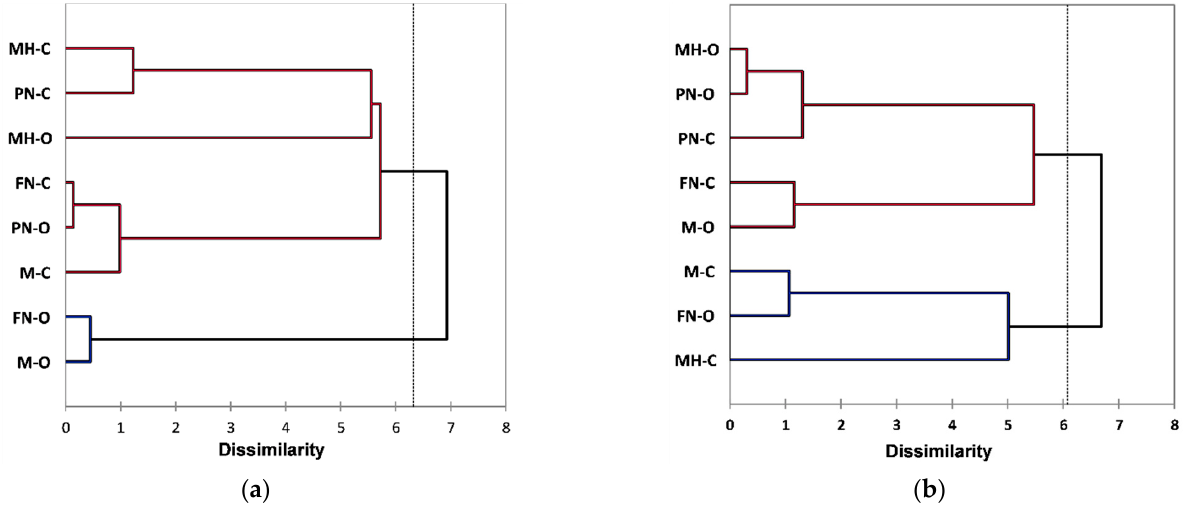
Figure 3. Dendrograms showing the cluster patterns for red grape skin extracts based on: ( a ) FTIR data; ( b ) Raman data. As can be observed for the FTIR data processing using AHC (Figure 3a), classification reveals two main clusters: the first included FN-O and M-O extracts and the second included the rest of the extracts, a good classification based on vineyard type, relative to all four varieties, cannot be observed. However, at a lower dissimilarity level (2 ÷ 5), subclusters division allows a classification based on vineyard type, excepting PN-O; also, a dif- ferentiation can be made for each grape variety between organic and conventional extracts. From all grape varieties, Merlot and Feteasca Neagra show the most notable differ- ence between organic and conventional vineyards (M-O vs. M-C and respectively FN-O vs. FN-C), the corresponding extracts for each variety, organic and conventional, being assigned in the two main clusters. The AHC classification based on the Raman data (Fig- ure 3b) shows two main clusters, the first of which includes MH-O, PN-O, PN-C, FN-C